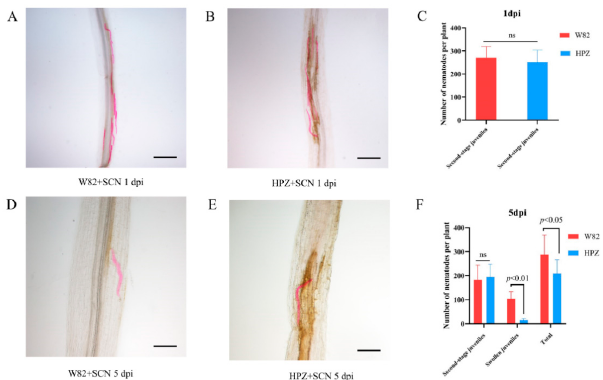
Figure 1. SCN (soybean cyst nematode) juveniles; infection rate and development state assay in HPZ and W82. Each soybean seedling was inoculated with 2000 second-stage SCN juveniles, and the infection rate was assayed at 1 dpi in W82 and HPZ ( A – C ), A: second-stage SCN juveniles infected the root of W82, bar = 500 µ m, B: second-stage SCN juveniles infected the root of HPZ, bar = 500 µ m, C: total number of second-stage SCN juveniles infected the root of W82 and HPZ, values are the mean of the number of SCN, bar, standard error. The development state was assayed at 5 dpi ( D – F ), D: SCN juveniles developed into the swollen stage in W82, bar = 200 µ m, ( E ) the development of SCN juveniles was delayed in HPZ, bar = 200 µ m, ( F ) total number of SCN di ff erent state juveniles in W82 and HPZ at 5 dpi, values are the mean of the number of SCN, bar, standard error. Pictures of SCN juveniles in the soybean root were taken by an OLYMPUS DP80 light microscope (Olympus, Tokyo, Japan). Nematode infection and development data were checked for normality with the Kolmogorov–Smirnov or Shapiro–Wilk test, then the t-test method was used to analyze these above data with SPSS software. Each soybean cultivar contained 10 replicates, ns: not significant, p < 0.05, p < 0.01 means a significant di ff erence was found between each